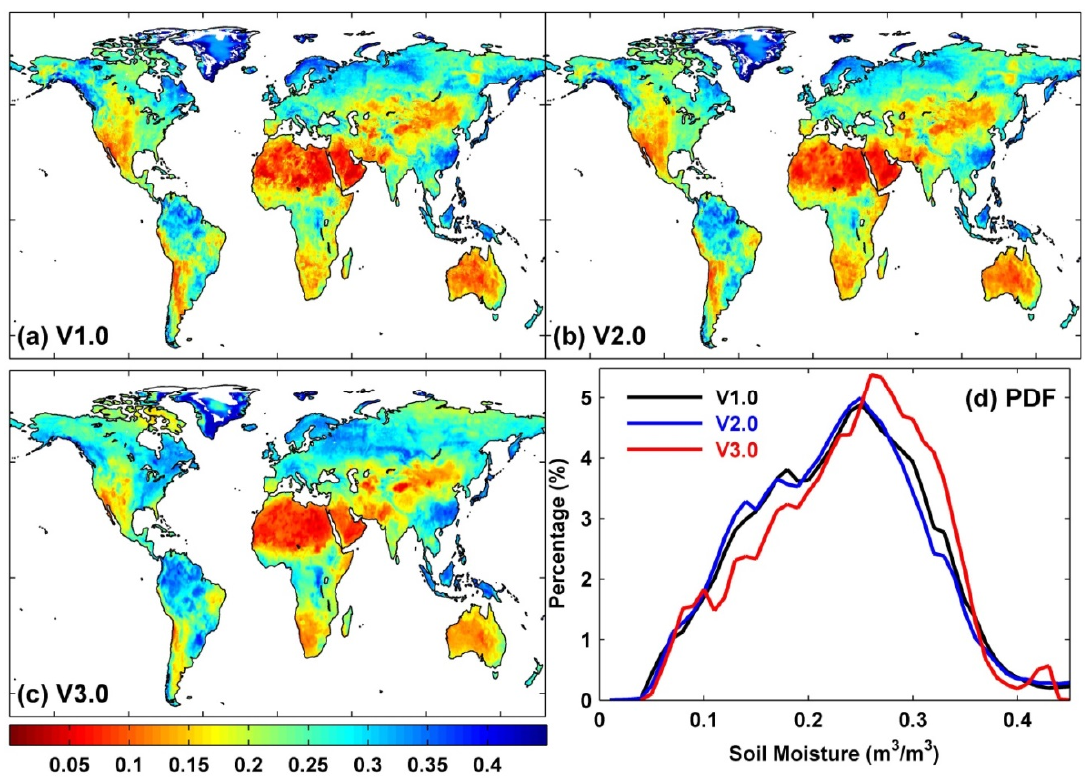
Figure 1. Average soil moisture (in m 3 / m 3 unit) for ( a ) SMOPS version 1.0 over the 1 June 2007–3 November 2011 period, ( b ) SMOPS version 2.0 over the 16 November 2011–20 September 2016 period, ( c ) SMOPS version 3.0 over the 1 April 2015–31 December 2019 period, as well as ( d ) global domain-averaged frequency probability as a function of average soil moisture for the three version SMOPS blended soil moisture data products during the corresponding product time periods.